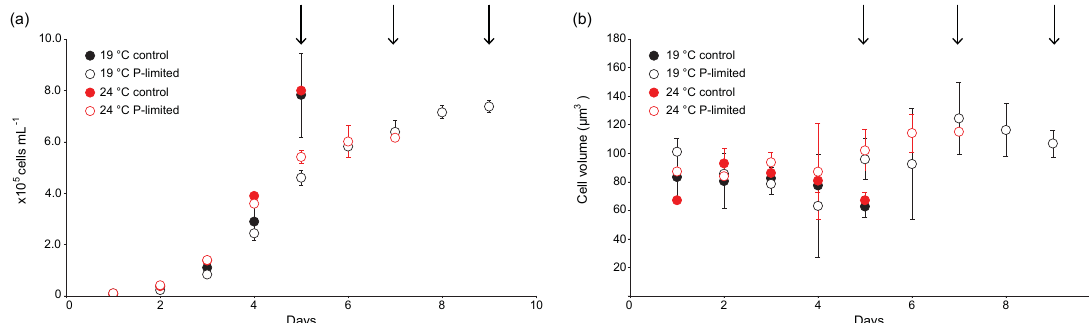
Figure 1. (a) Cell concentrations and (b) cell volume over time in batch cultures of Emiliania huxleyi grown at 19 and 24 ◦ C in control and P-limiting medium. Error bars denote the standard deviation of mean triplicate measurements of triplicate cultures. Arrows indicate when cultures were